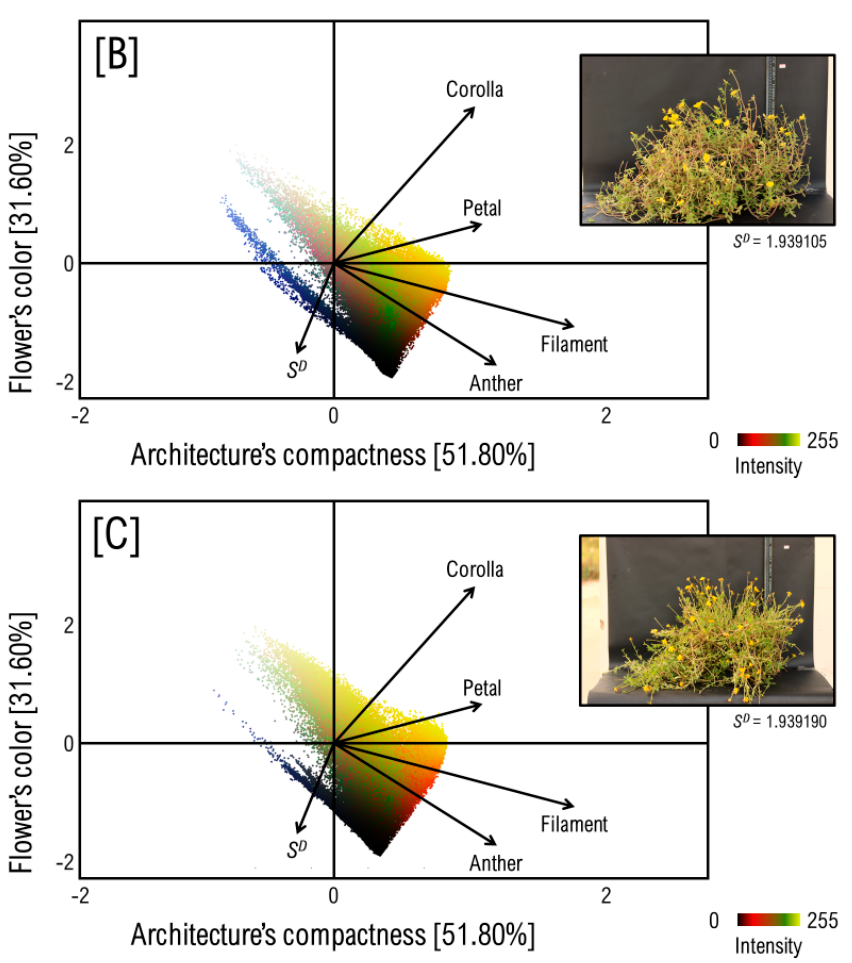
Figure 4. Mapping the botanical and computational features of flower and the architecture of yellow-flower samples of P. umbraticola . The sequence of alphanumerical symbols, from ( A – C ), relates to the increasing fractality of the pattern in the representation of the digital image.